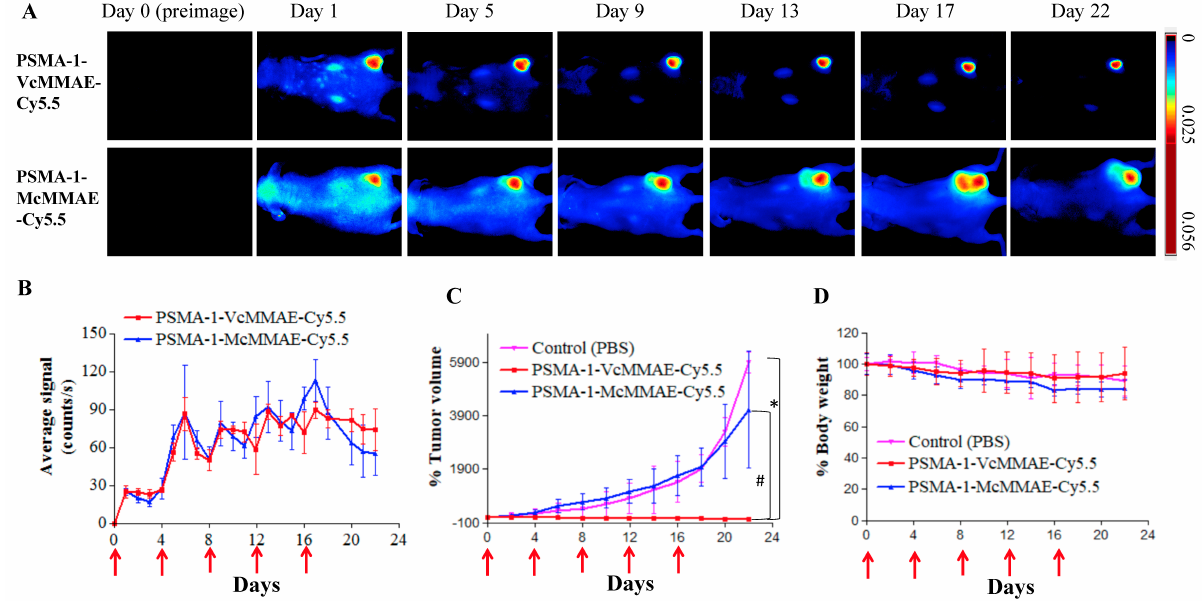
Figure 5. Treatment of mice bearing heterotopic PC3pip tumor with 160 nmol/kg of PSMA-1-MMAE-Cy5.5 conjugates. Mice received 160 nmol/kg of either PSMA-1-VcMMAE-Cy5.5 or PSMA-1-McMMAE-Cy5.5 every 4 days with a total of five doses (as indicated by the red arrows). ( A ) Fluorescence images of mice bearing PC3pip tumor treated with PSMA targeted drug conjugates on different days. Bright fluorescent signal was observed on PC3pip tumors. Representative images are shown of n = 5. ( B ) Quantification of average fluorescent signal on PC3pip tumors. The average fluorescent signals on the tumors were about the same for both conjugates. Values are mean ± SD, n = 5. ( C ) In vivo tumor inhibition of PSMA-targeted drug conjugates using heterotopic PC3pip tumors. Significant tumor regression was only observed in mice treated with PSMA-1-VcMMAE-Cy5.5. Values represent mean ± SD of five animals. (*, PSMA-1-VcMMAE-Cy5.5 vs. PBS, p < 0.05; #, PSMA-1-VcMMAE-Cy5.5 vs. PSMA-1-McMMAE-Cy5.5, p < 0.05). ( D ) Body weight changes of mice treated with PSMA-1-drug conjugates. No significant body weight loss was observed between the three groups. Values are mean ± SD, n =